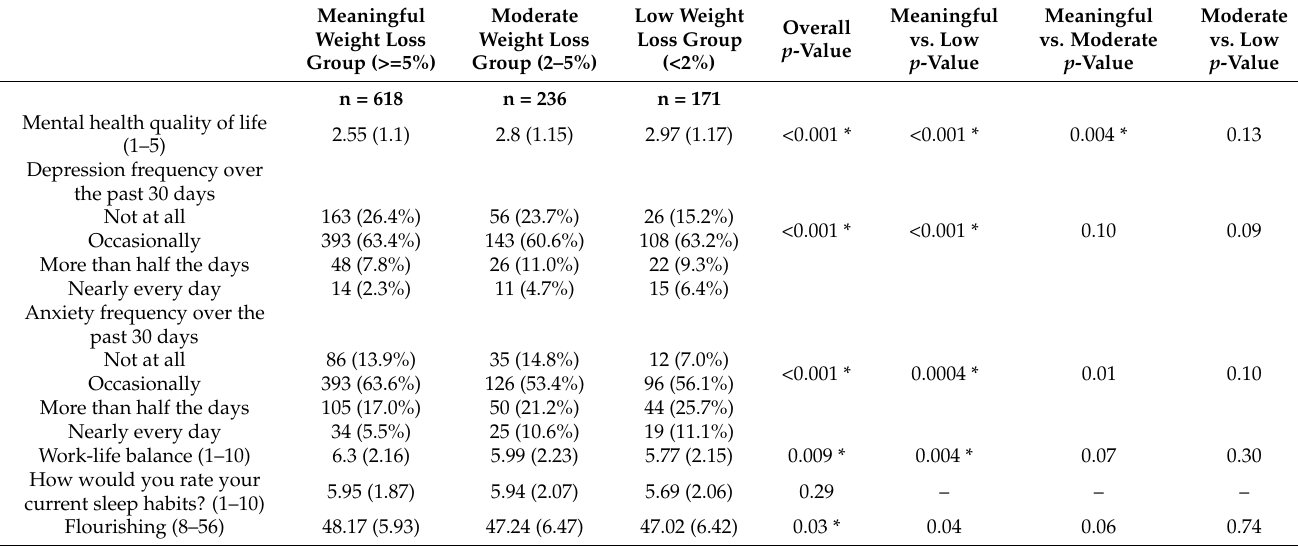
Table 2. Overall sociodemographic characteristics for all respondents ( n =